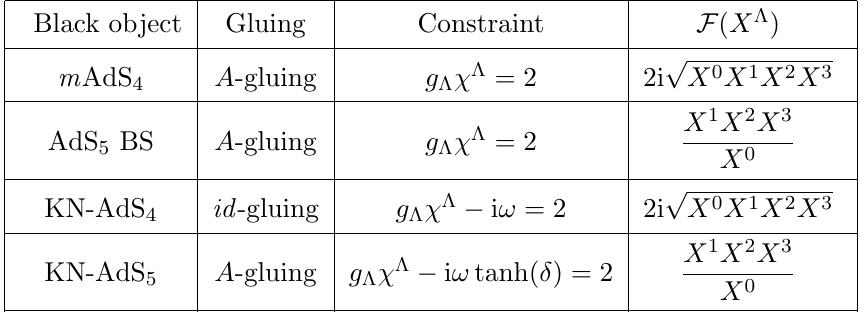
Table 1 . In this table, m AdS 4 refers to magnetically charged black holes in AdS 4 with a twist, BS=black strings and KN=Kerr-Newman. All the black objects in AdS 5 are considered after dimensional reduction to four dimensions. The prepotential and gaugings can be read o(cid:11) from the existing consistent truncations of AdS 4 (cid:2) S 7 and AdS 5 (cid:2) S 5 . The gaugings are purely electric. In suitable normalizations we can set g (cid:3) = 1 for AdS 4 black holes, g (cid:3) = f 0 ; 1 ; 1 ; 1 g for AdS 5 BS and